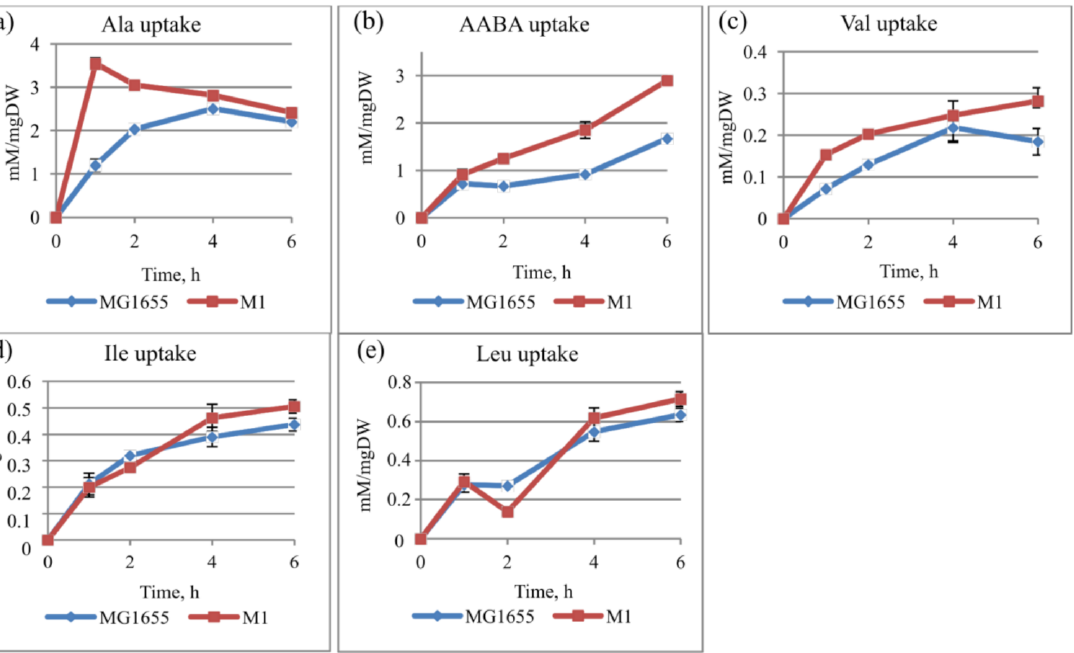
Figure 3. Time courses of amino acid uptake. Strains E. coli K12 MG1655 and M1 (MG1655 cat - P L - cycA ) were incubated in parallel in N − minimal medium containing ( a ) 50 mM alanine (Ala), ( b ) AABA, ( c ) valine, ( d ) isoleucine, or ( e ) leucine (Leu) at 37 ◦ C for 6 h. The uptake rate (mM/mg DW) was calculated as the consumed AA (the extracellular concentration was subtracted from the initial one) normalized to the dry weight (mg DW) value. The data are the mean values of three replicates with standard